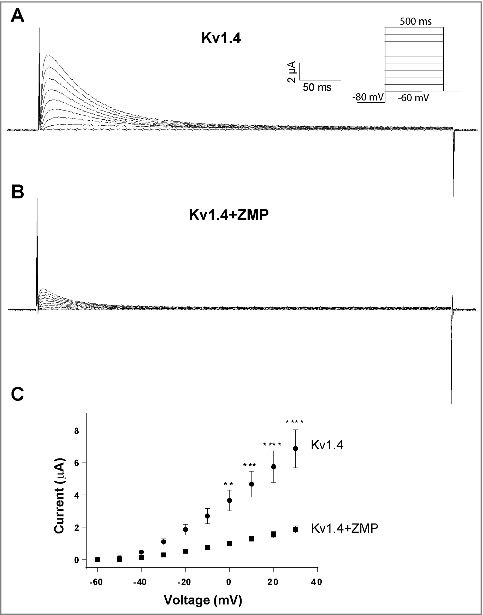
AMPK activation promote reduced Kv1.4 currents.TEVC recordings of Xenopus laevis oocytes expressing Kv1.4 channels. Representative current traces of Kv1.4 current following depolarization steps in control oocytes (A) and from oocytes injected with 100 ng ZMP to activate AMPK (B). Insert: Step protocol. (C) Current-voltage relationship of Kv1.4 currents in control oocytes or oocytes injected with ZMP. ZMP significantly down-regulated the current level by 73%. Kv1.4 (n = 10) and Kv1.4+ZMP (n = 7).